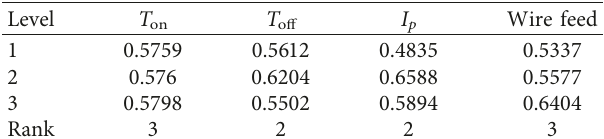
Figure 9: EDS analysis for L 6 workpiece using zinc-coated brass wire as a tool. Table 21: Response table for brass wire.